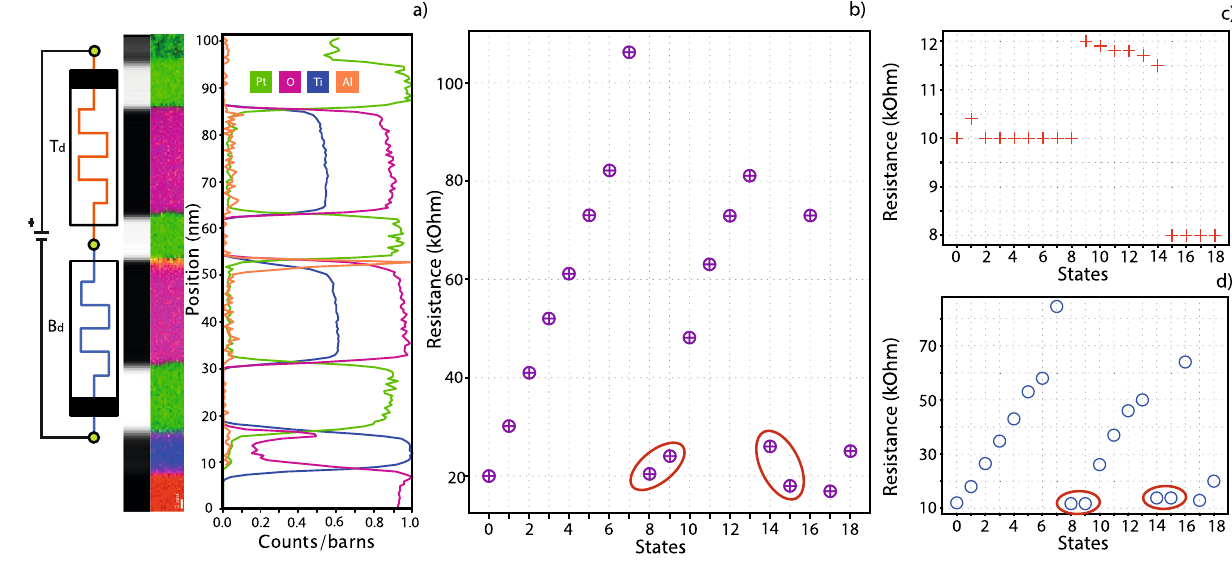
Figure 5. Simultaneous switching of antiserially connected memristors. In this case the voltage applied should have opposite effects on the devices, i.e. it could increase resistance in one and decrease it in the other. ( a ) Antiserial connection schematic and EELS image of the stack. In this case the Bottom device used was a bilayer stack to ensure cross-fabricational device functionality. Electroforming was used to force T d to exhibit opposite polarity of switching from B d . ( b ) State evolution of the Complete device through application of voltage pulses across the aggregate stack. Exceptions to this rule are states 9 and 15, shown inside the red ellipse, where individual switching was used for the Top device, and was carried on to the Complete device, in a process already described in Fig. 2. ( c , d ) State evolutions of antiserially connected devices. Evidently from ( c ), the device state is not affected as much when using lower voltages (+ 2 or − 2 V), which is what was supplied to the whole stack, leading to the conclusion that higher stimulus would be needed to switch it. For the Top device to switch, a pulse of increased voltage (+ 3 or − 3 Volts) had to be separately supplied to it. This led to switching behavior seen in states 9 and 15. During states 9 to 14, whole-stack pulsing is more successful in affecting the whole stack (switching voltage + 2 V) and there was a gradual decrease of T d resistance at the same time as it was increased for B d . The Complete device evolution reflects all changes that happen to both devices. For example, transitions into states 9 and 15 are wholly dependent on T d switching, while states 1–8 and 10–14 closely follow the evolution of B d . States 8,9 and 14,15 are encircled in subfigure ( d ) to, highlight non-switching behaviour of the B d , as voltage was only applied in T d